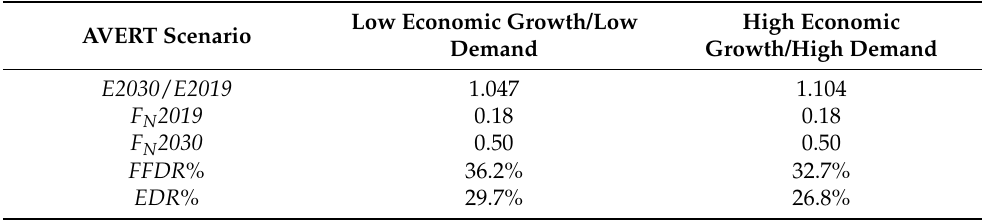
Table 1. AVERT model input parameters for the low and high electricity demand scenarios in Nevada for